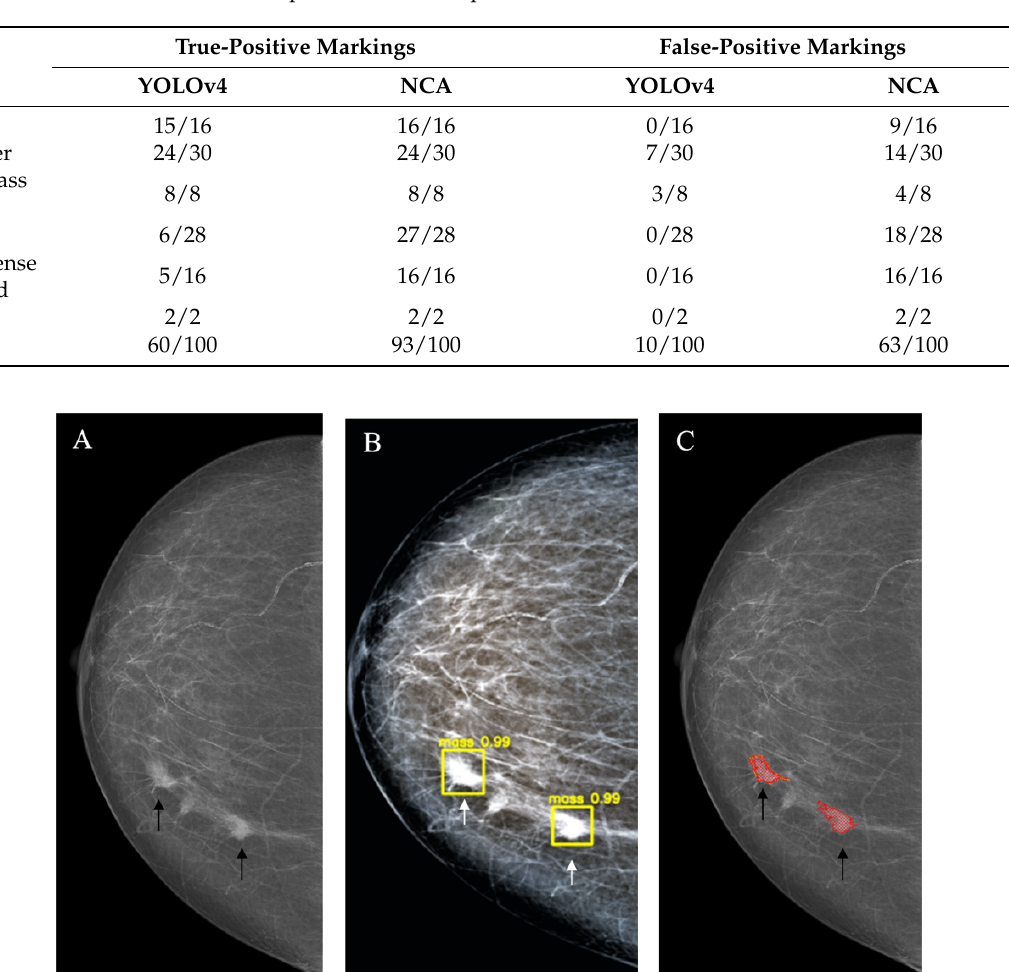
Table 3. The rate of true-positive and false-positive outcomes for YOLOv4 and NCA-based CADs.